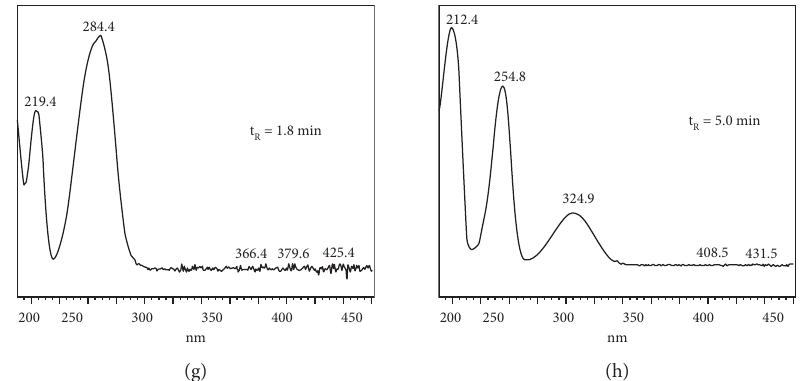
Figure 4: Spectra of degradation products of t-RSV. The spectrum of t-RSV (a) at a retention time ( t c-RSV (b), and its degradation product at 3.2 min, which is believed to be resveratrone